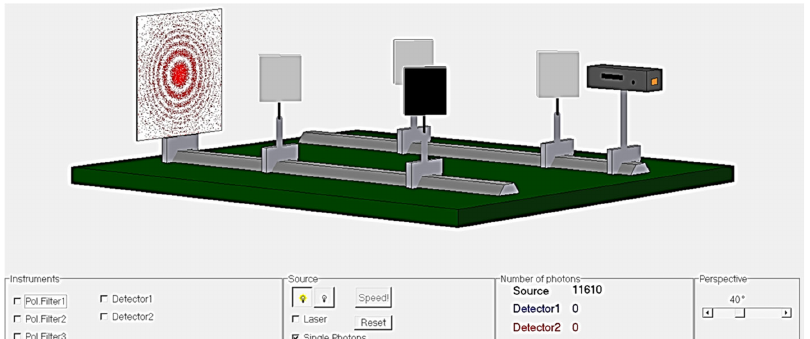
FIG. 5. Screen shot of the computer simulation of a large number of single photons propagating through the MZI. Simulation developed by Albert